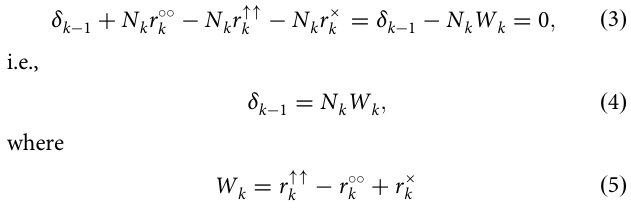
Fig. 1 Minimal generic model of hierarchically differentiating tissues and corresponding cell lineage trees. a cells are organized into n + 1 hierarchical levels based on their differentiation state. The bottom level (level 0) corresponds to tissue-speci fi c stem cells, higher levels represent progressively differentiated progenitor cells, and the top level (level n ) is comprised of terminally differentiated cells. Four microscopic events can occur with a cell: (i) asymmetric cell division, (ii) symmetric cell division with differentiation, (iv) symmetric cell division without differentiation and (iv) cell death. The number of cells on level k under normal homeostatic conditions is denoted by N k . Under homeostatic conditions each level (except for the terminally differentiated one at the top) provides the next level with newly differentiated cells at a rate δ k . Terminally differentiated cells at the top of the hierarchy cannot divide and are destined to wear away (i.e., leave the tissue). b At progenitor levels k > 0 in fully developed tissues under homeostatic conditions self-renewal replenishes only a fraction of the cells lost as cells arrive by differentiation from lower levels and, as a result, progenitor cells always have an inherent proliferative disadvantage. c Cell lineage trees in “ wild type ” tissues are shown for two different values of a uniform ampli fi cation factor γ k = γ . Given the same rate of production of terminally differentiated cells (terminal tips of the cell lineage tree) larger values of γ correspond to a steeper decline in cell division rates towards lower levels, and slower dividing stem cells with longer progenitor sublineages (cf. the two sublineages highlighted with bold arrows). Longer sublineages for larger values of γ are the result of increased self-renewal (i.e., more symmetric cell division events shown in blue) and, equivalently, decreasing proliferative disadvantage of progenitor cells (cf. Eq. levels based on their differentiation state 8 : The bottom level (level 0) is comprised of tissue-speci fi c stem cells, while higher levels (levels k , where 0 < k < n ) contain progressively more differ- entiated progenitors, and the top level (level n ) corresponds to the terminally differentiated cells (Fig. 1a). During tissue homeostasis the stem cell level produces differentiated cells at a rate of δ 0 , while the differentiation rates of higher levels (denoted by δ k for level k ) are progressively larger. The increasing tendency of the differentiation rates of the progenitor levels (0 < k < n ) is speci fi ed by the level-speci fi c ampli fi cation factors γ k = δ k / δ k − 1 , which relate the differentiation rate of a progenitor level to that of the level below it (cf. Fig. 1b).